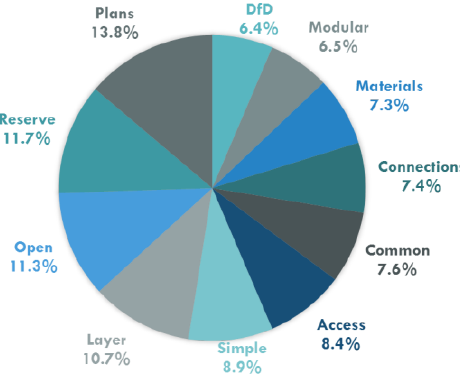
Figure 14. Relative effectiveness of design-based adaptability enablers. Data from [36], Elsevier, 2016.